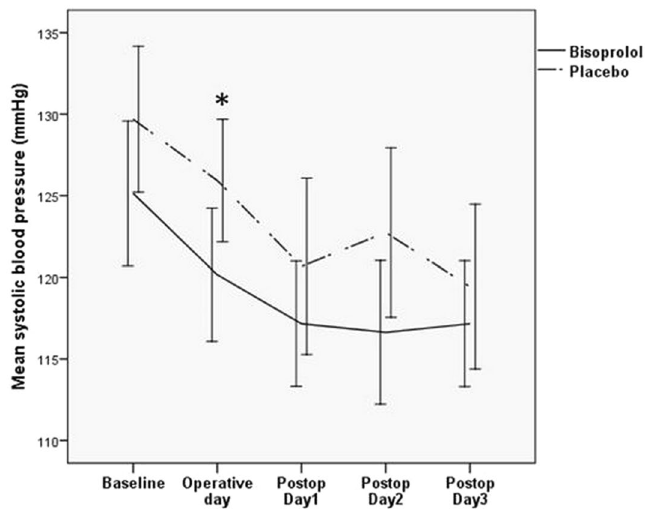
Figure 3. The effects of bisoprolol on systolic blood pressure during perioperative period compared to placebo. The systolic blood pressure was significantly reduced after surgery compared to baseline in both bisoprolol (solid line), and placebo (dashed line) groups. When compared between 2 groups, the systolic blood pressure on operative day was significantly lower in bisoprolol compared to placebo. *Statistically significant P < 0.05, compared to placebo.